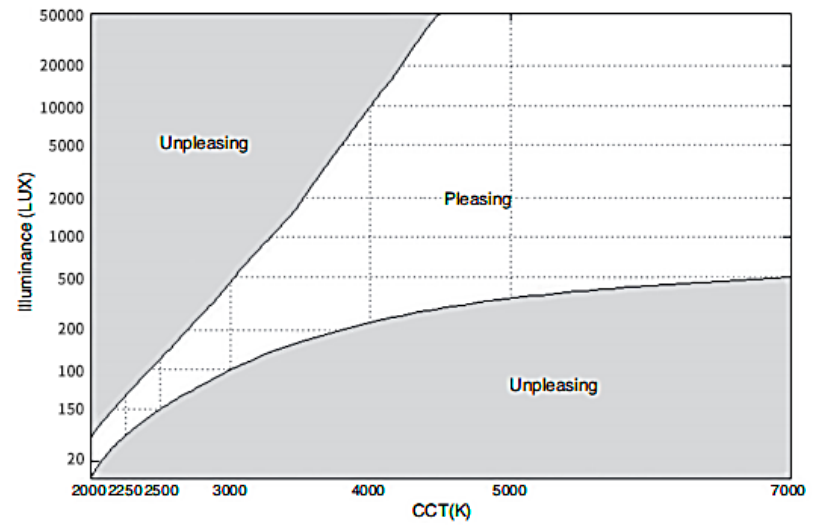
Figure 1. Curve of Kruithof [5].